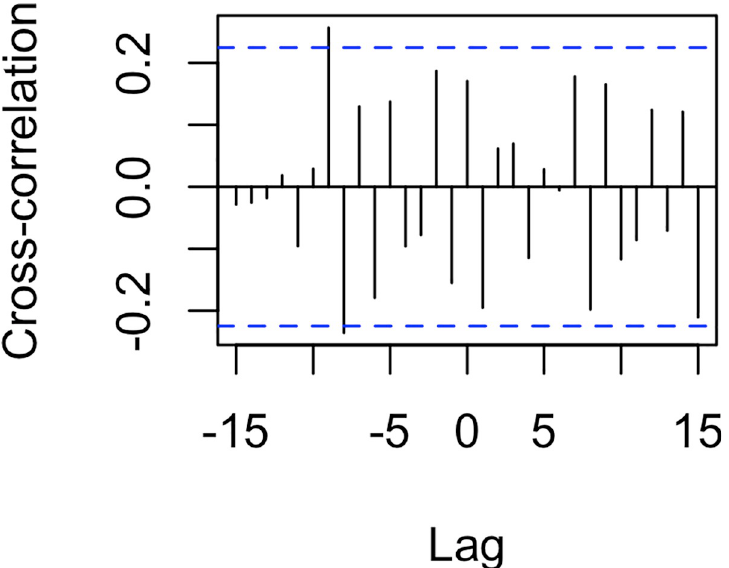
Fig 17. Cross-correlation plot for social cohesion and count of daily original